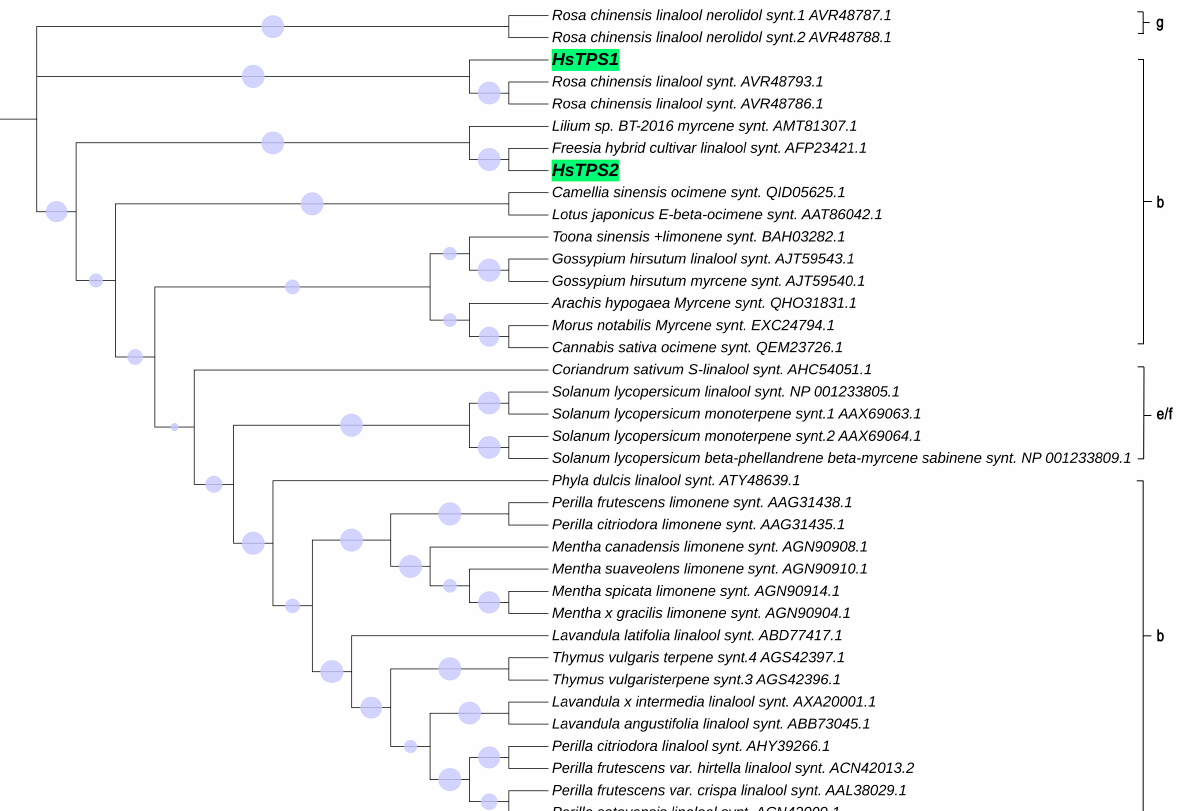
Figure 2. Results of phylogenetic analysis of terpene synthase proteins from H . ‘So Sweet’ (Hs TPS1 ,Hs TPS2 ) and other plants, done using 1000 replications for bootstrapping by MEGA 6 program. Circle at the branches of the tree shows bootstrap values.